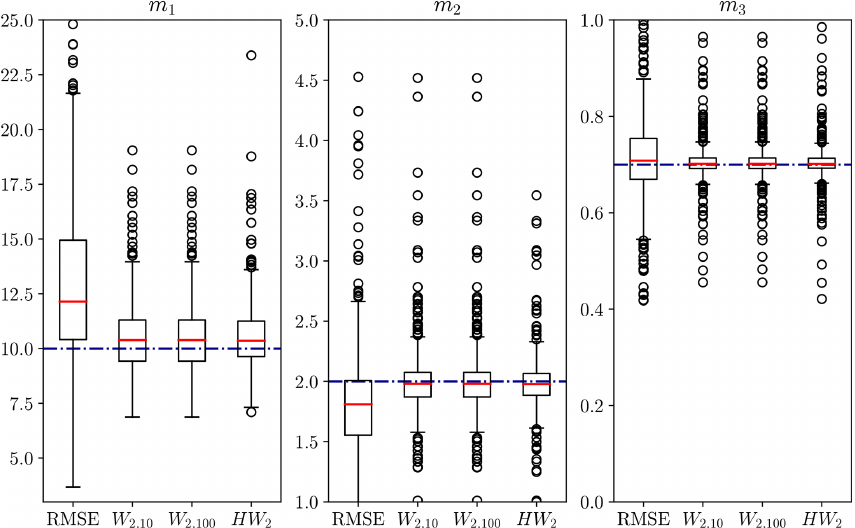
Figure 15. Calibrated model parameters for 500 rainfall events generated randomly using the method in Appendix A under the influence of timing errors. Optimisation used the Nelder–Mead algorithm initialised at the true model parameters of (10, 2, 0.7). Red solid line shows the median calibrated parameter, blue dash-dot line the true model parameter. Optimisation used RMSE, Wasserstein distance with γ = 10, 100 penalty terms, and hydrograph–Wasserstein